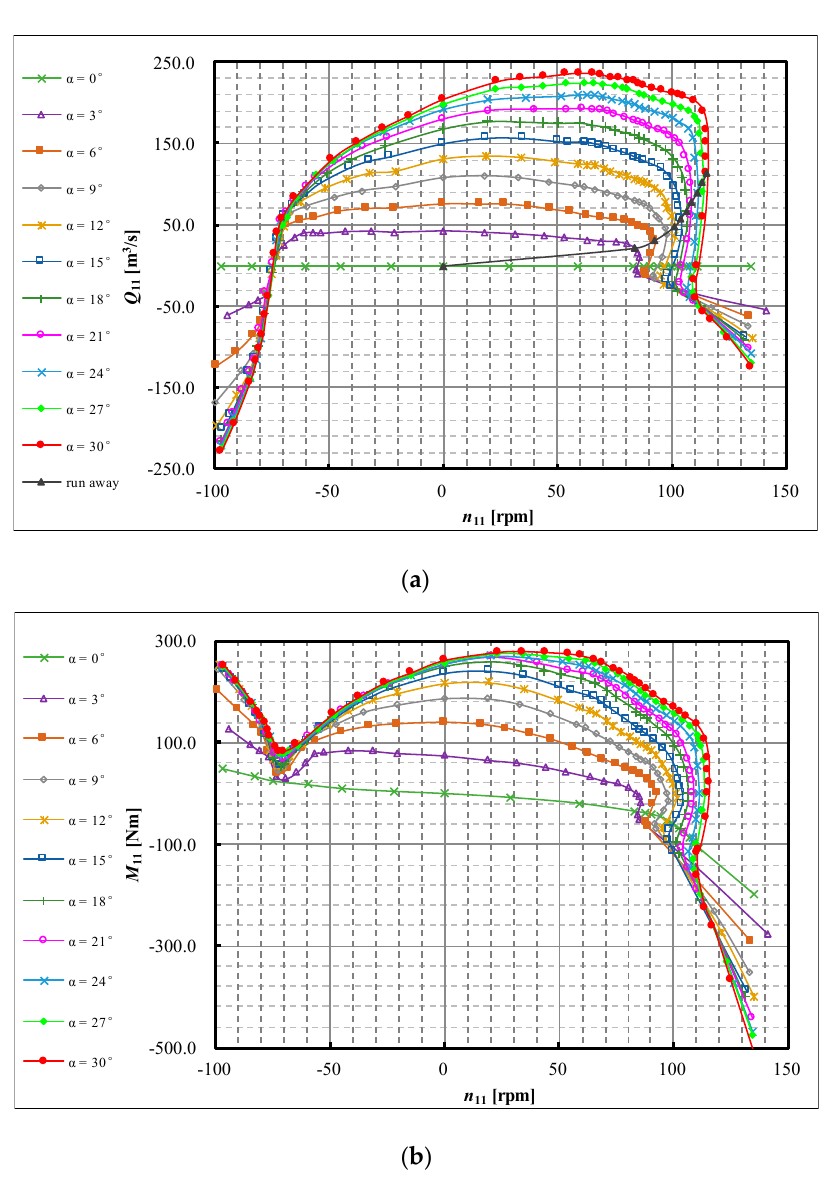
Figure 5. Four-quadrant characteristics of the RPT: ( a ) Q 11 ~ n 11 ; ( b ) M 11 ~ n 11 .